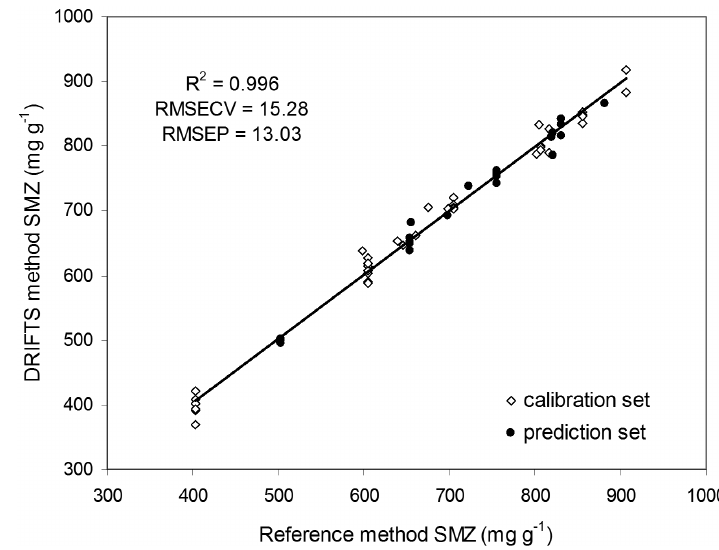
Figure 4 - Reference HPLC values versus predicted SMZ values for siPLS model using intervals 6, 7 and 10 and 4 latent variables.